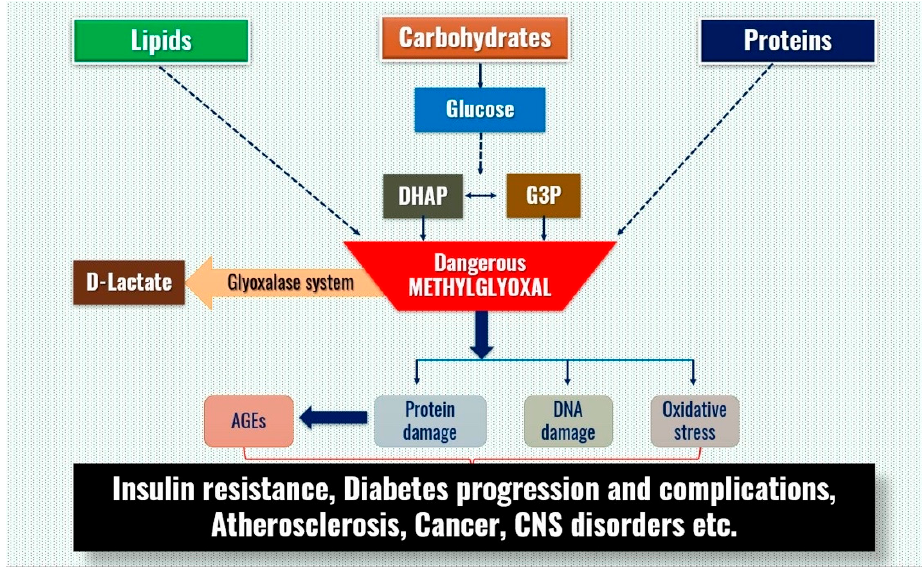
Figure 1. Schematic representation of Glyoxalase/methylglyoxal system. The cytotoxic methylglyoxal is rendered harmless after conversion to D-lactate by Glo-1. Any imbalance in this system leads to intracellular and extracellular damage.